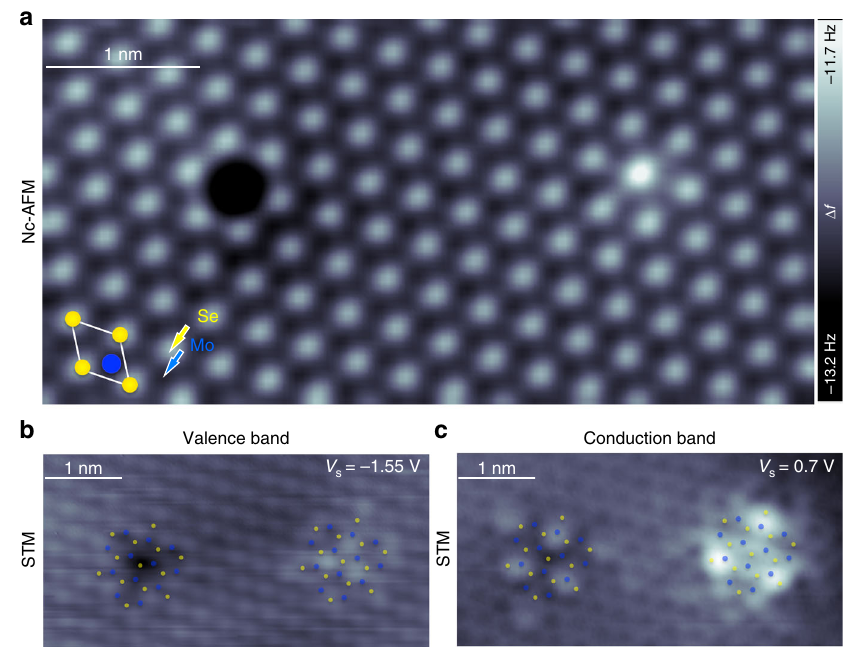
Fig. 1 Nc-AFM and STM images of the O Se top and bottom defects in 2D-MoSe 2 . a CO-tip nc-AFM image of O Se top in the top Se layer of 2D-MoSe 2 (left) and O Se bottom in the lower Se layer facing the graphene substrate. Atomic resolution STM constant current images on the same area as in a , measured at the b valence and c conduction bands edges. Se (yellow dots) and Mo (blue dots) locations are indicated in the images